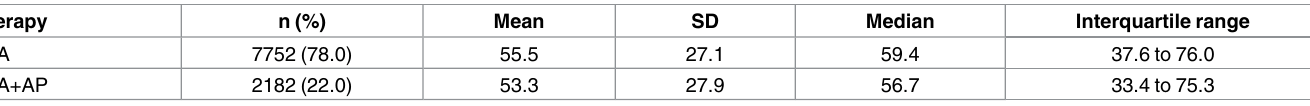
AP, antiplatelet; SD, standard deviation; VKA, vitamin K